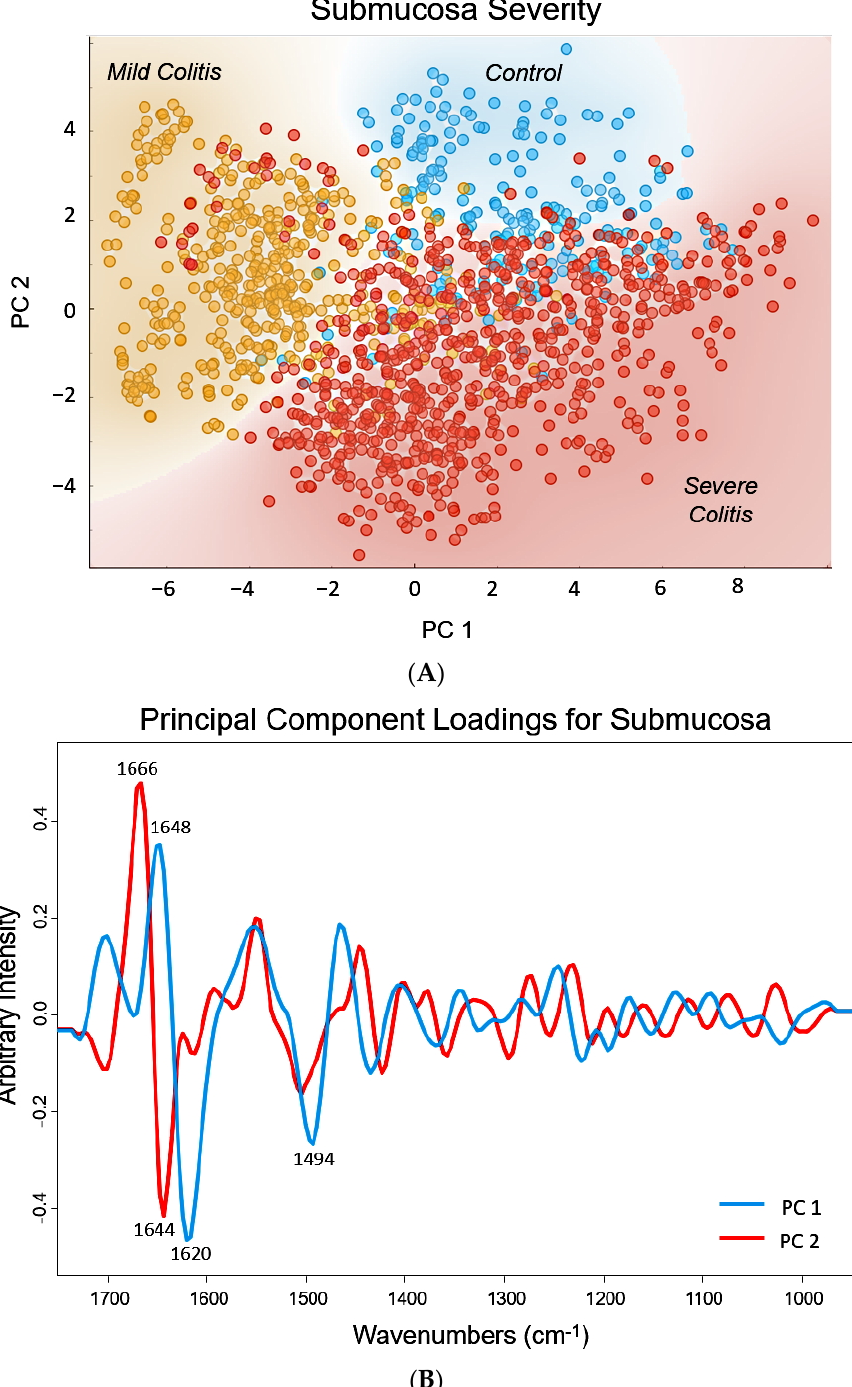
Figure 7. Unsupervised classification of colitis severity using the submucosa tissue spectra in a PCA model. ( A ) Plot of PC1 and PC2 using PCA from spectra obtained from the submucosa of healthy, mild, and severe colitis demonstrating separation between these classes. ( B ) Loadings plot for PC1 and PC2 demonstrating key features in the wavenumber bands that separate the classes.